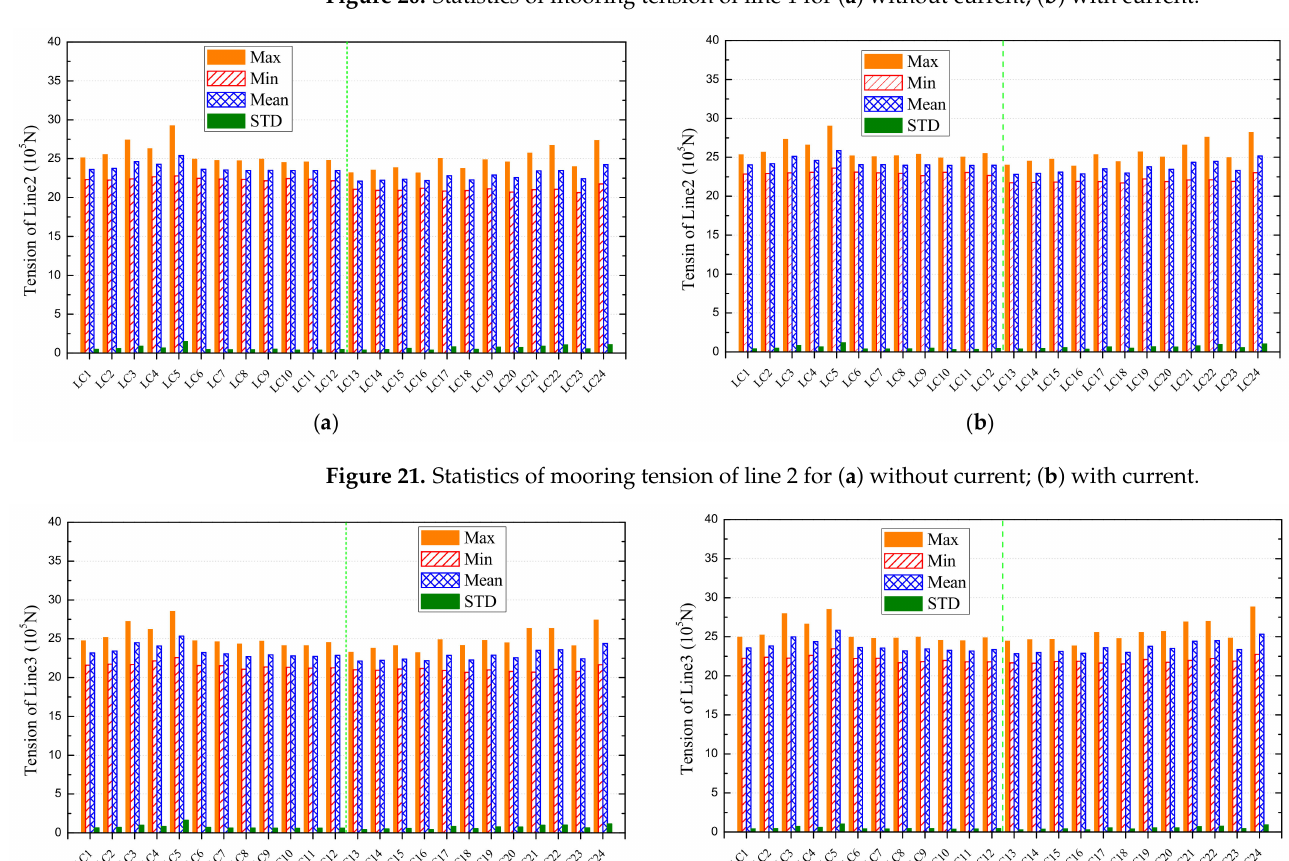
Figure 20. Statistics of mooring tension of line 1 for ( a ) without current; ( b ) with current.